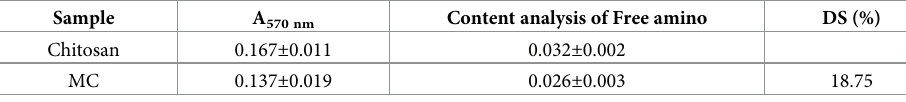
Table 1. The Degree of Substitution (DS) of Mannose-Modified Chitosan (MC) (mean ± SD, n =